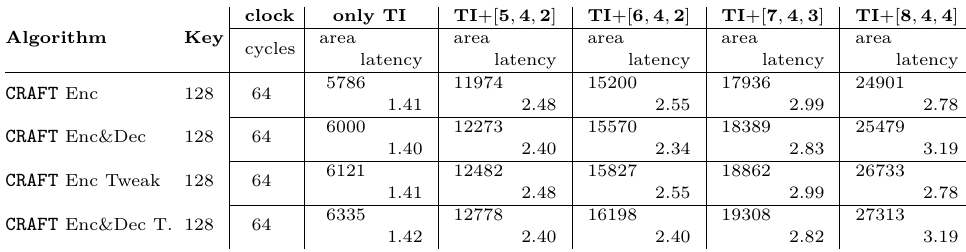
Table 11: Area (GE) and Latency (ns) of round-based Threshold Implementations of -bounded univariate adversary with an [ n, k, d ] CRAFT with 3 shares considering an M t = d − 1 code, using a 40 nm commercial ASIC